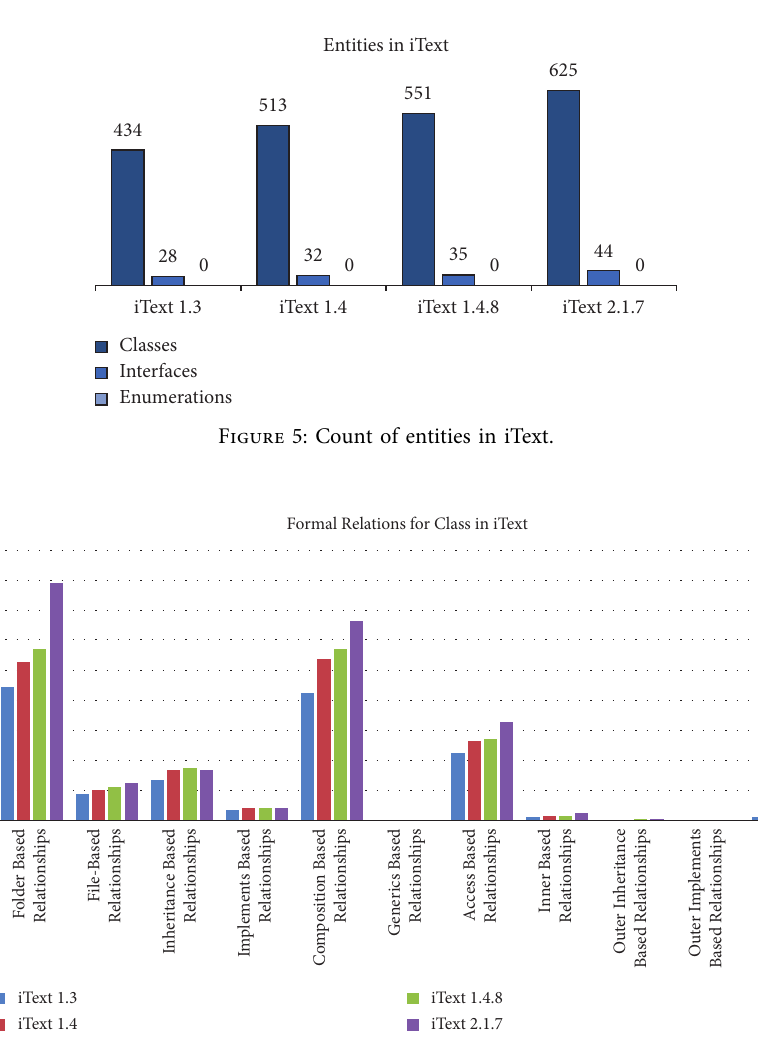
Figure 6: Count of formal relationships for class in iText. (iii) For interfaces outer extends-based relationships, (ii) For classes the most used relationships are folder- outer composition-based relationships, and com- based relationships while access-based relation- position-based relationships are not used while ships, implements-based relationships, inheritance- extends-based relationships are only used in JUnit based relationships, and file-based relationships 4.8. Also, among used relationships, folder-based have a good frequency of occurrence.